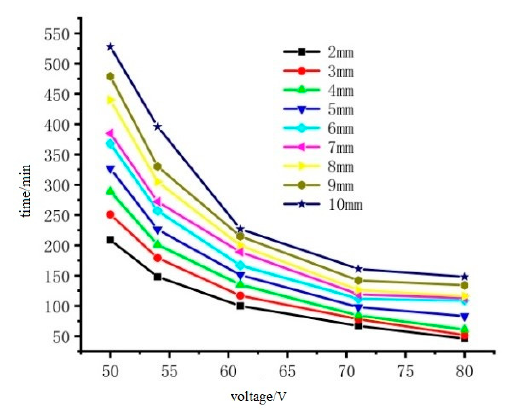
Figure 22. The relationship between ice melting time and thermal insulation and input voltage.